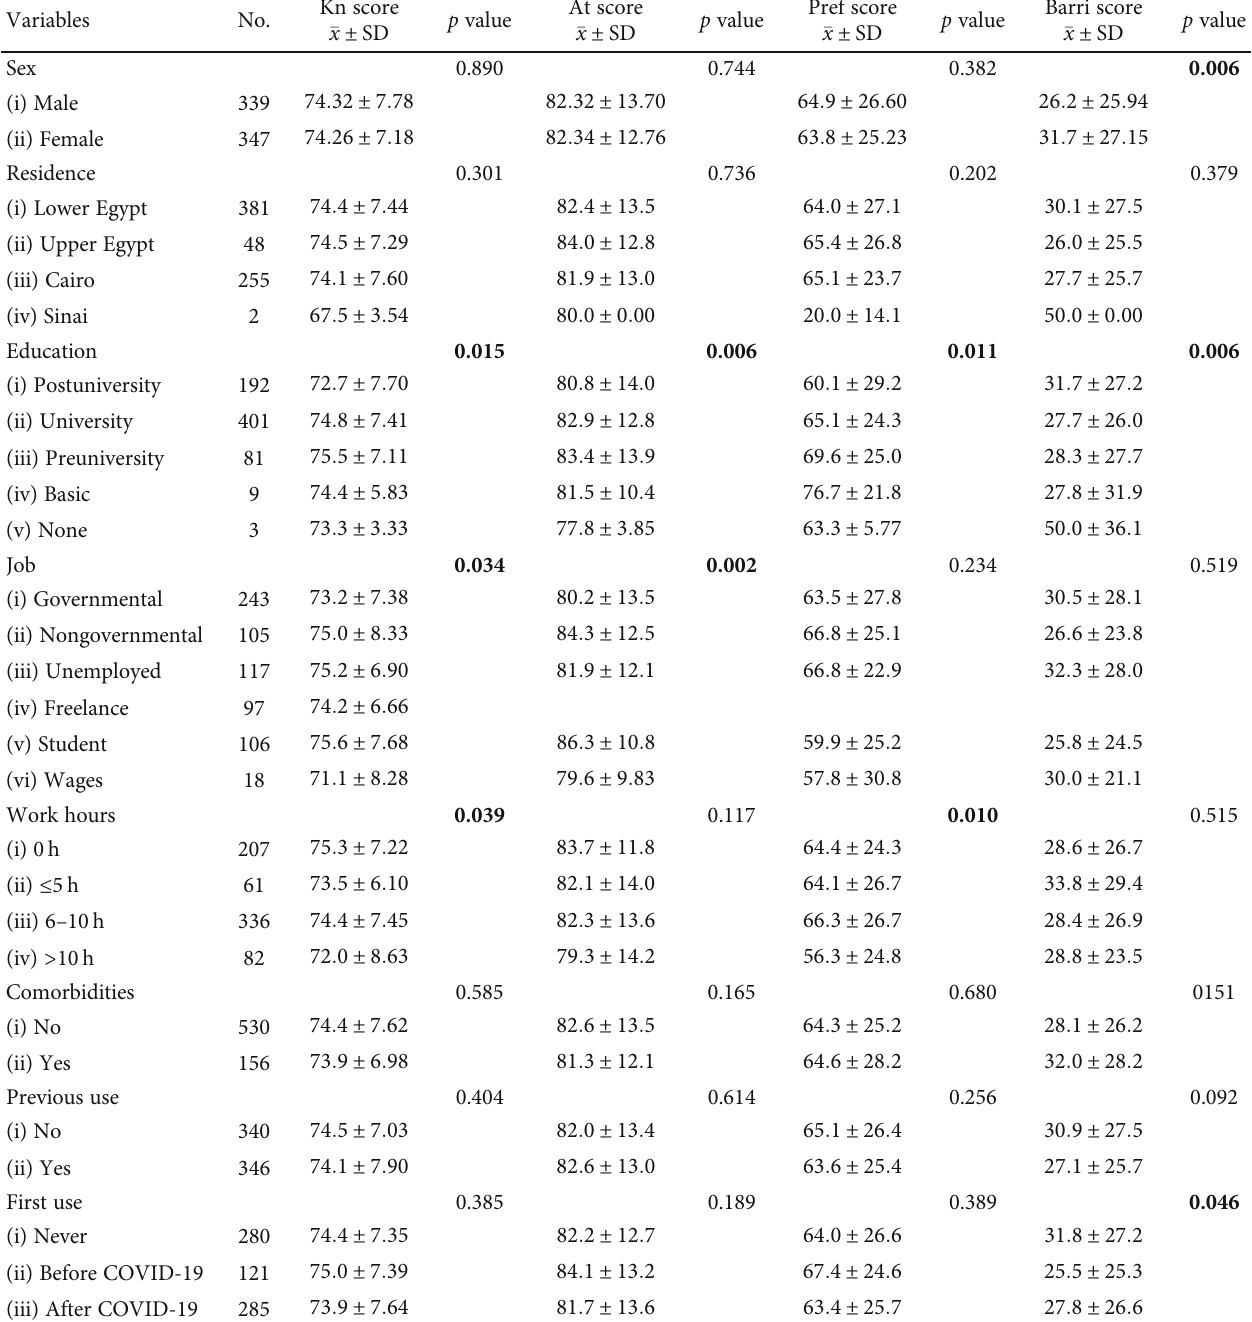
Table 3: Comparisons of knowledge, attitude, preference, and barrier scores according to sociodemographic characteristics ( n = 686 ). Variables No.